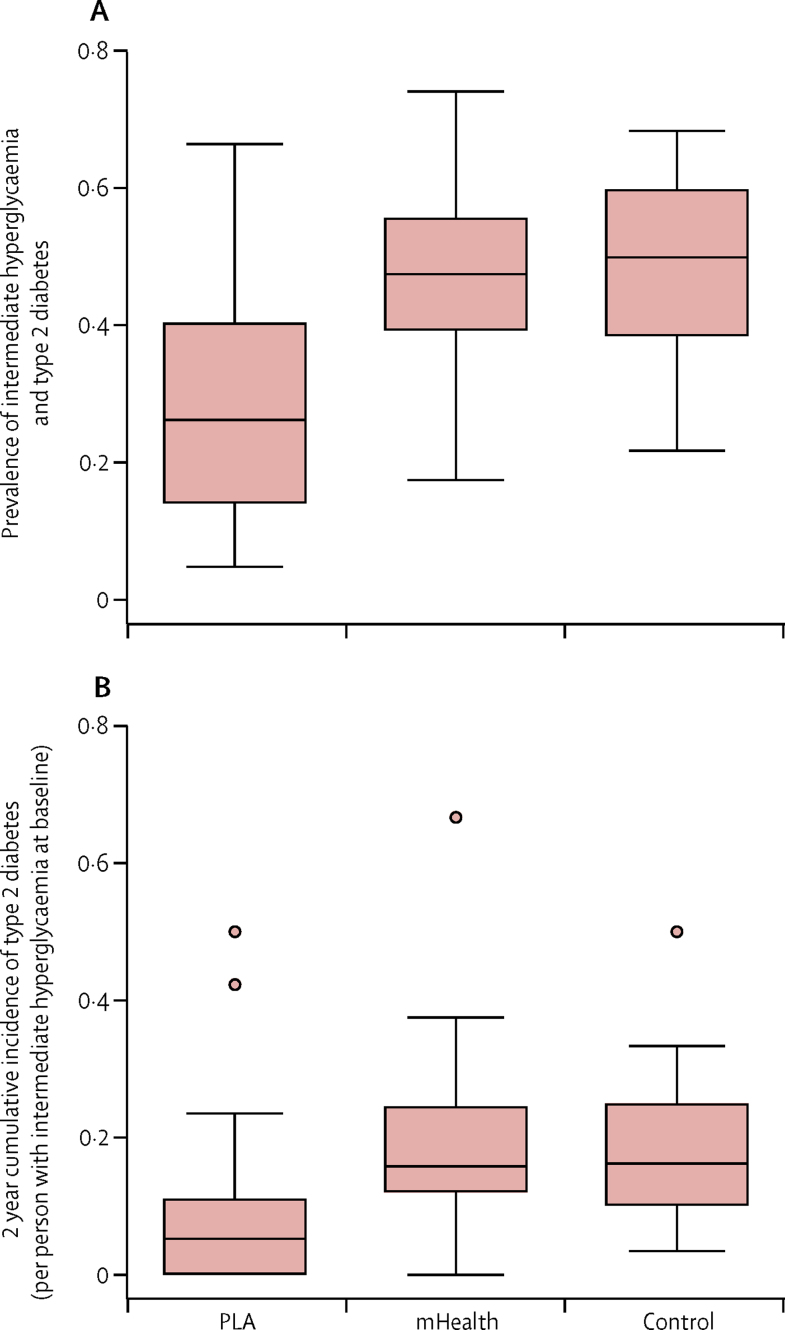
Allocation box-plots showing (A) a cluster-level summary of intermediate hyperglycaemia and diabetes at end of study and (B) cluster-level 2 year cumulative incidence of diabetes among the hyperglycaemic cohortBox-plot shows median, minimum and maximum values and interquartile range.